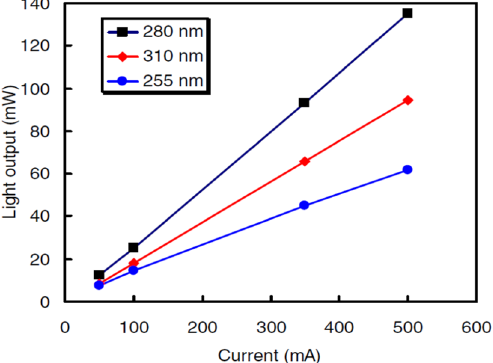
Figure 30. I–L characteristics of DUV LEDs operated in pulsed-current mode. Reproduced with permission. [84] Copyright 2014, IOP.